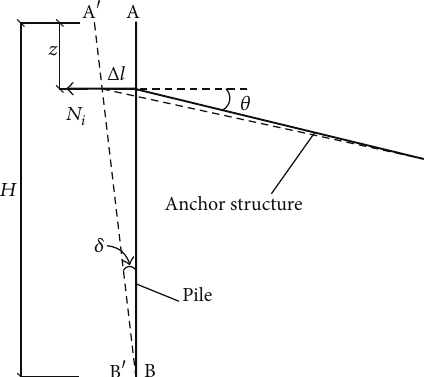
Figure 3: Lateral deformation of pile-anchor support